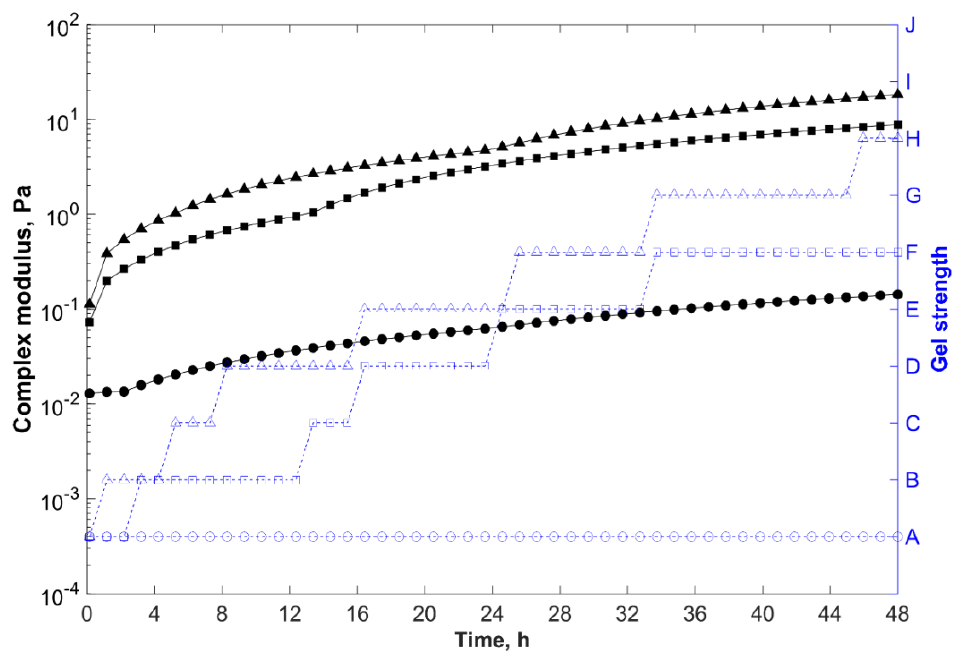
Figure 3. Complex modulus ( ─ ) and gel strength (- -) versus time for samples prepared in field water at 85 °C, with 0.8 wt % of clay, 0.5 wt % of PEI, and different polymer concentrations.